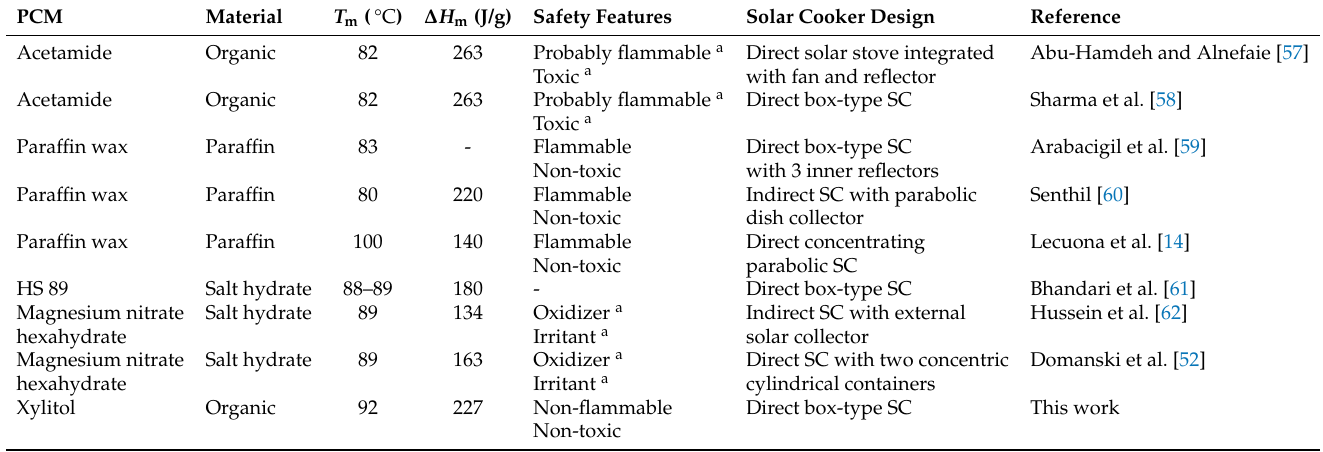
Table A1. Summary of PCMs used in solar cooker applications at low